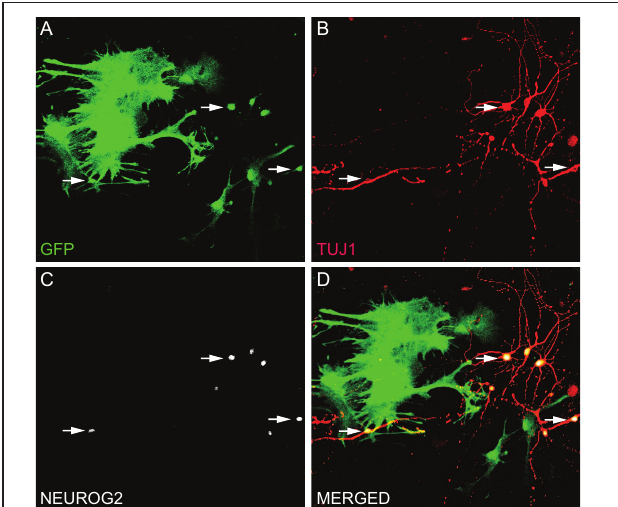
FIGURE 1 | Direct conversion of astrocytes into neurons in vitro . (A–D) Culture of astrocytes isolated from the postnatal cerebral cortex of transgenic mice expressing green fluorescent protein (GFP) under the control of the astrocyte-specific promoter hGFAP (Nolte et al., 2001). Astrocytes were transduced with NEUROG2 2h after plating and processed for immunocytochemistry after 7 days using antibodies against GFP (green, A and D ), NEUROG2 (white, C and D ) and the neuronal marker TUJ1 (red, B and D ). Observe that astrocytes transduced with NEUROG2 (three of these cells are highlighted with arrows) adopted a neuronal phenotype, but still express residual levels of GFP, indicating their astrocytic